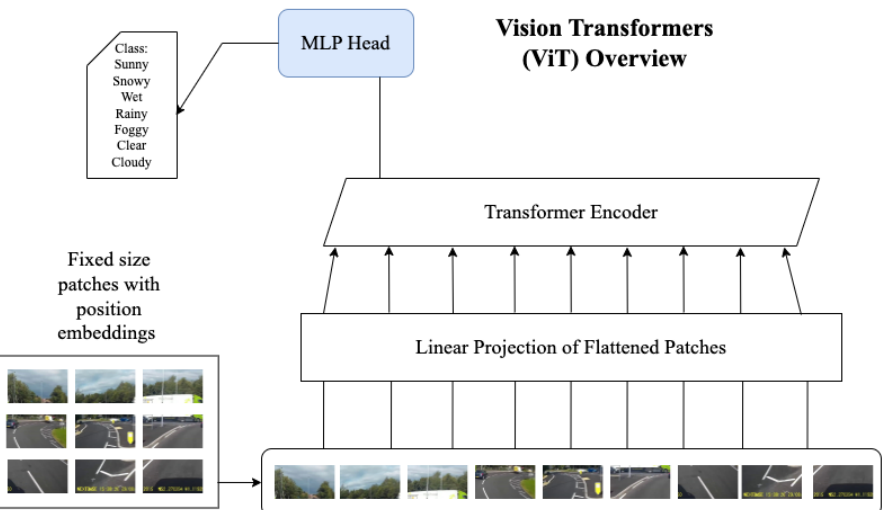
Figure 2. Transformer vision model architecture overview.